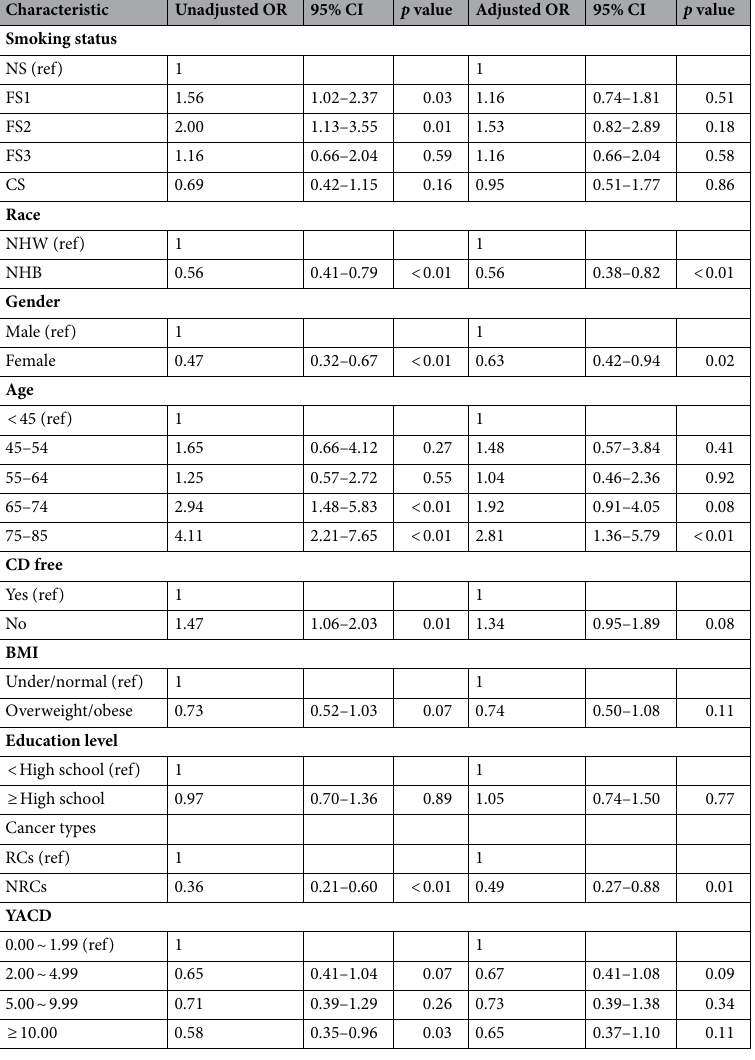
Table 3. Factors associated with a high-risk NLR level (NLR ≥ 3). The interaction term (race and smoking status) had statistical significance on subgroups: FS3 ( p = 0.03) and CS ( p = 0.01). NLR Neutrophil-to- lymphocyte ratio. CD Chronic diseases. BMI Body mass index. NHW Non-Hispanic White. NHB Non- Hispanic Black. NS Nonsmoker. FS1 Quit smoking 5 or more years before a cancer diagnosis. FS2